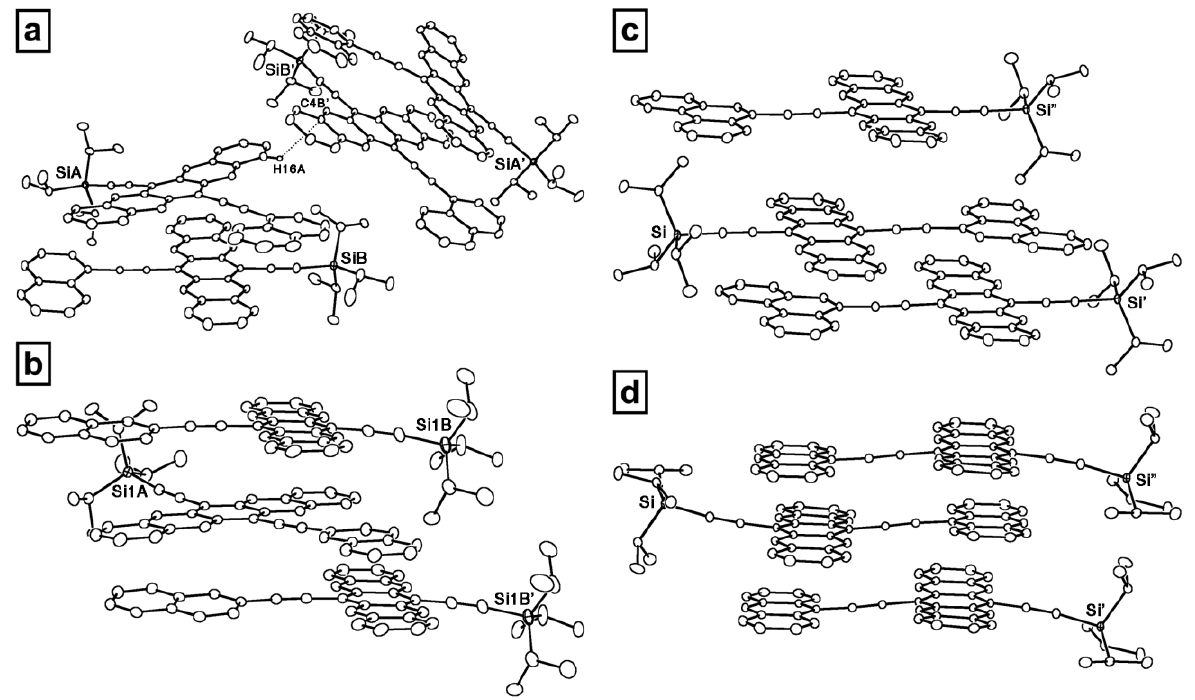
Figure 9. ORTEP representation illustrating solid-state packing of (a) 88 , (b) 87 , (c) 89 , and (d) 91 . Figure adapted with permission from reference [84]. Copyright 2009 Wiley- VCH Verlag GmbH & Co.